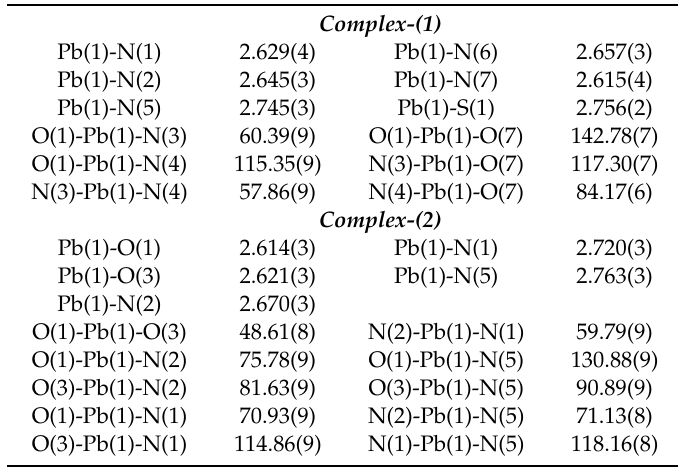
Table 2. Selected (Å) and bond angles ( ◦ ) for compounds ( 1 ) and ( 2 ) as determined by X-ray di ff raction.